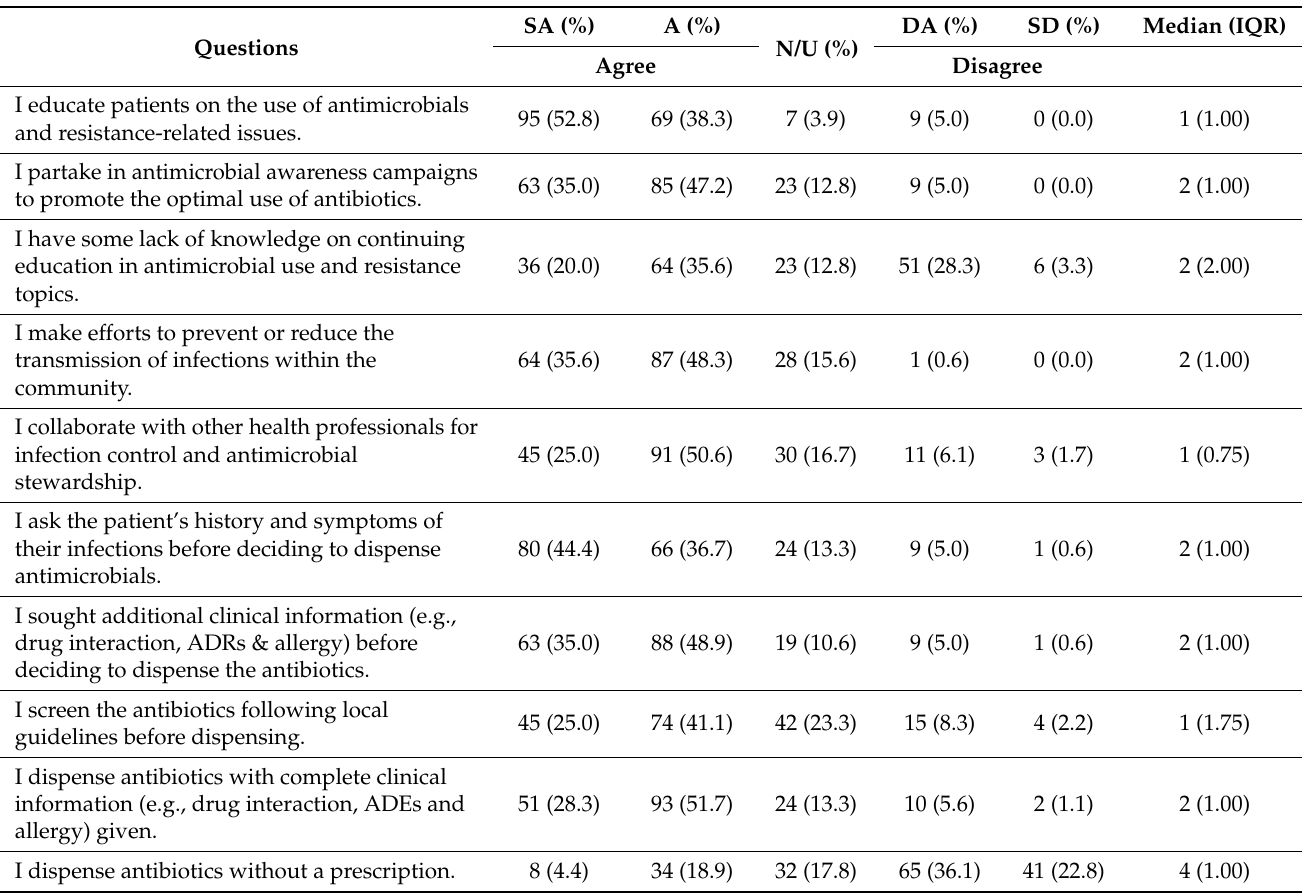
Table 4. Participants’ responses to